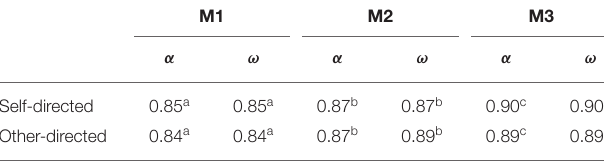
TABLE 9 | Internal consistencies of the TPA